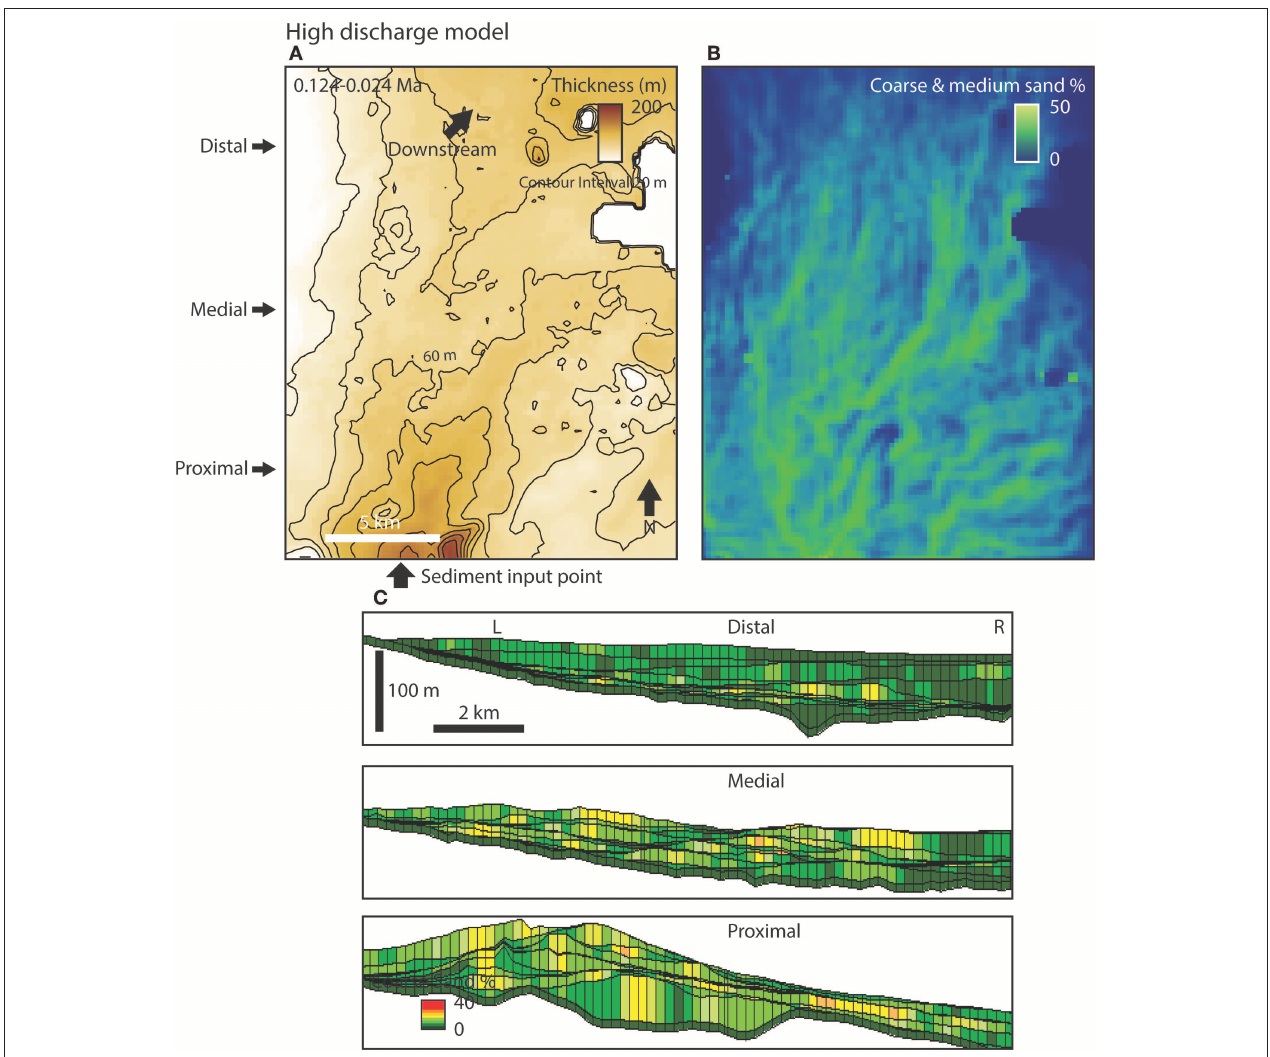
FIGURE 8 | (A) Isochore map of the high discharge model. (B) Coarse and medium sand percentage within the model. (C) Proximal, medial, and distal cross sections showing the coarse sand content in the model. Left (L) and right (R) orientations in cross sections are left and right in maps. Cross-section locations are indicated in part (A)